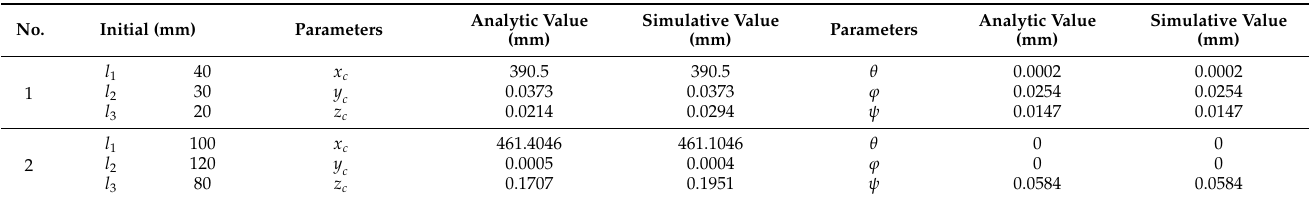
Table 2. The comparison of simulative and analytic values of positional posture parameters.